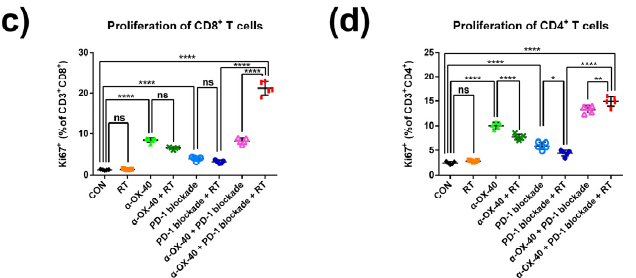
Figure 5. Proliferative T cell compartments in the tumor microenvironment. Representative flow cytometry plots of ( a ) CD8 + Ki67+ and ( b ) CD4 + Ki67+ T cells. The percentage of T cells expressing the proliferative marker Ki-67 in ( c ) CD8+ and ( d ) CD4+ T cell populations in the tumor microenvironment was calculated by flow cytometry. * p < 0.05, ** p < 0.01, *** p < 0.001, **** p < 0.0001. Abbreviations: CON, control; RT, radiotherapy; ns, not significant.